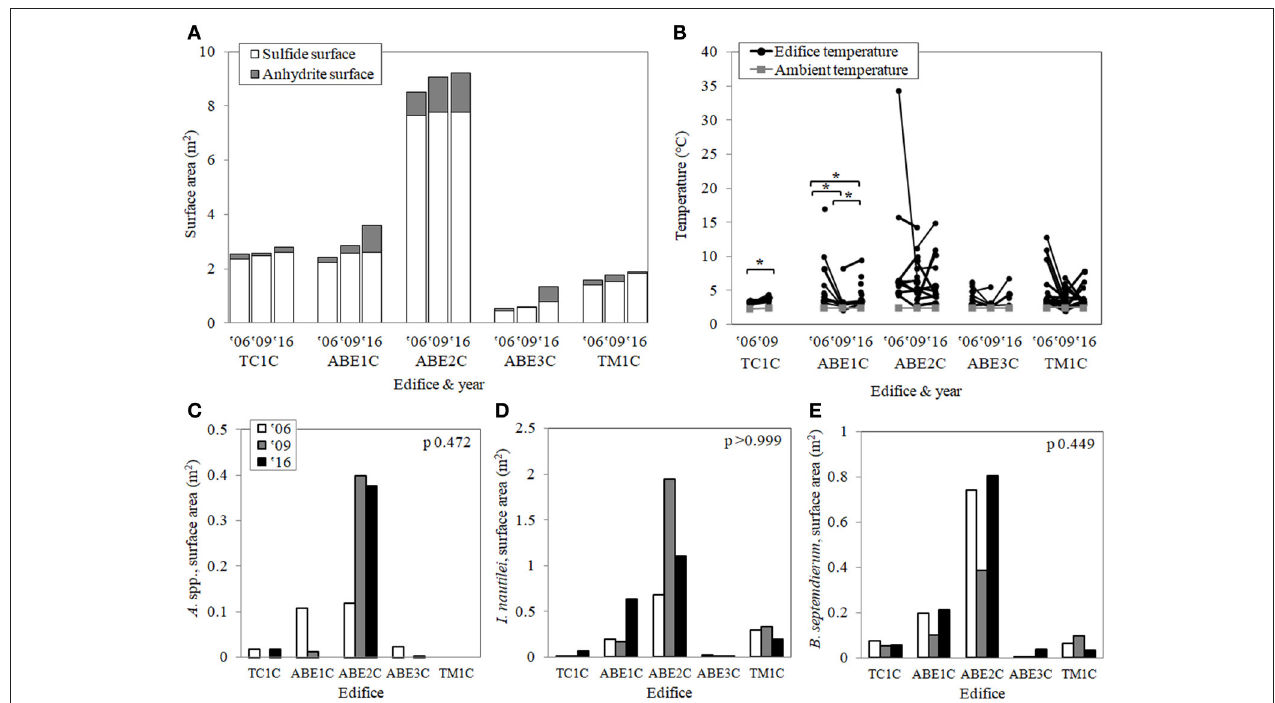
FIGURE 2 | The natural changes in (A) the size of the edifices and the two substrate types, (B) the fluid temperatures, and (C–E) the three chemoautotrophic bacteria-containing invertebrates for the five edifices over the study decade (2006, 2009, 2016). Lines show the pairings between repeated temperature measures and asterisks indicate a significant difference over time. A set of three bars show repeated faunal measures, but unlike with the temperature, there were no significant changes over time (Friedman tests where n = 5 edifices). For summarized statistics, see Tables 2 , 3 .